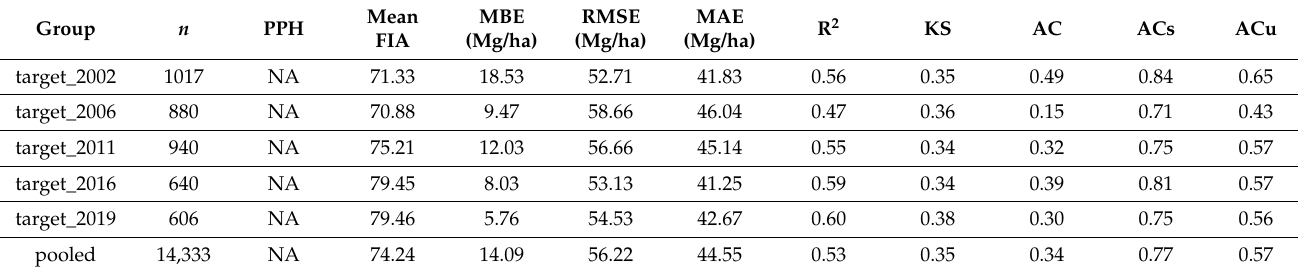
Table 2. Agreement statistics (SI-corrected)—pixel comparison.